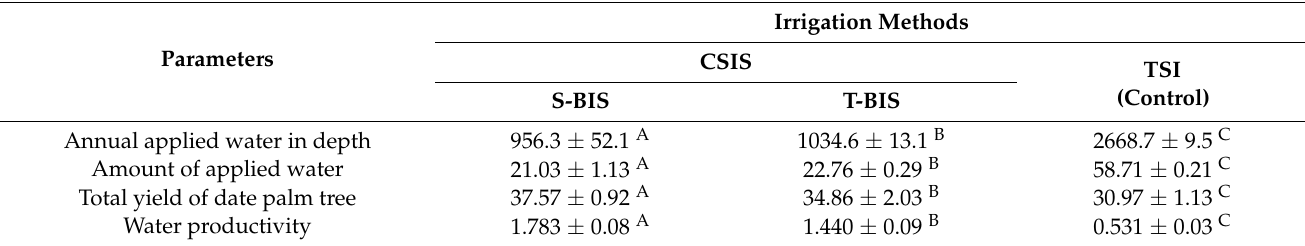
Table 3. Annual applied water (mm year − 1 palm − 1 ), amount of applied water (m 3 year − 1 palm − 1 ), the total yield of the date palm tree (kg palm-1), and water productivity (kg m − 3 ) under sensor-based irrigation schedule (S-BIS) and time-based irrigation schedule (T-BIS) methods of the controlled subsurface irrigation system (CSIS) compared with the traditional surface irrigation (TSI as a Control) method of the experimental season of